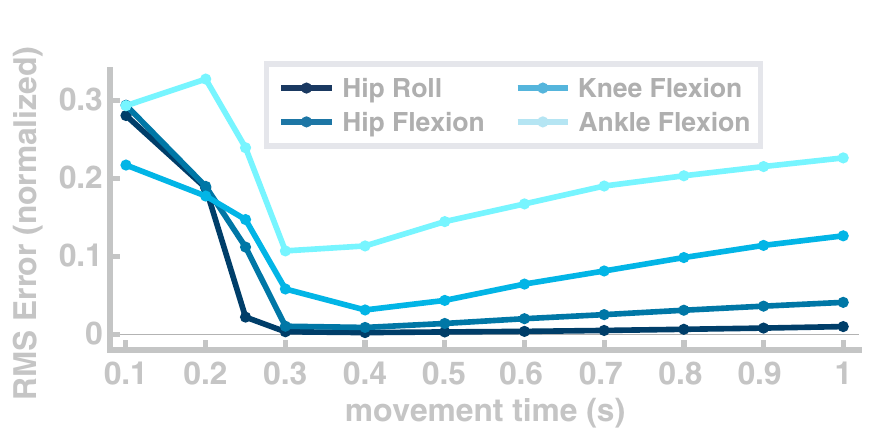
Figure 5. Joint-space error for single movements with different movement times. Each curve shows the root- mean-squared error the respective